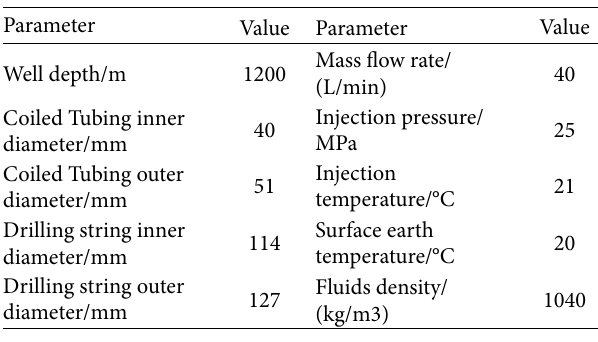
Table 1: Calculation parameters.